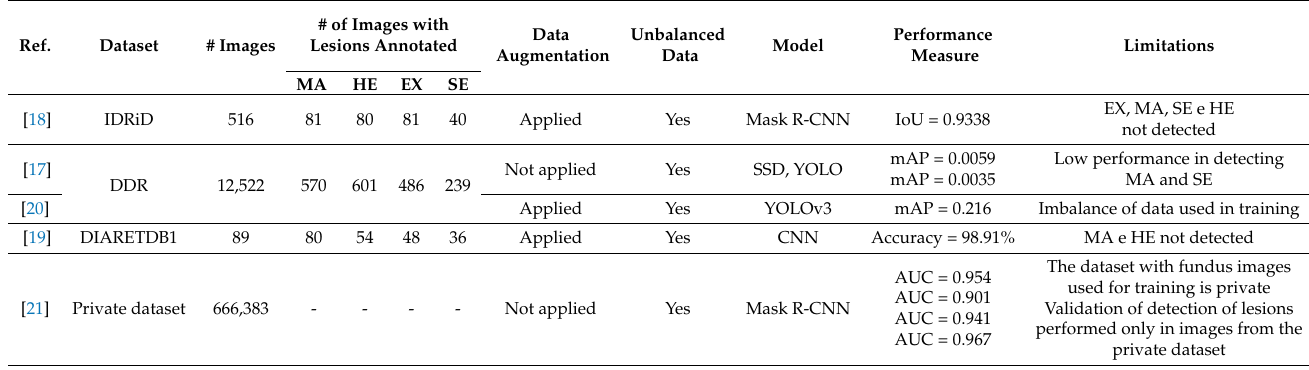
Table 1. Comparison between related work that use deep learning to classify, segment and detect objects in diabetic retinopathy